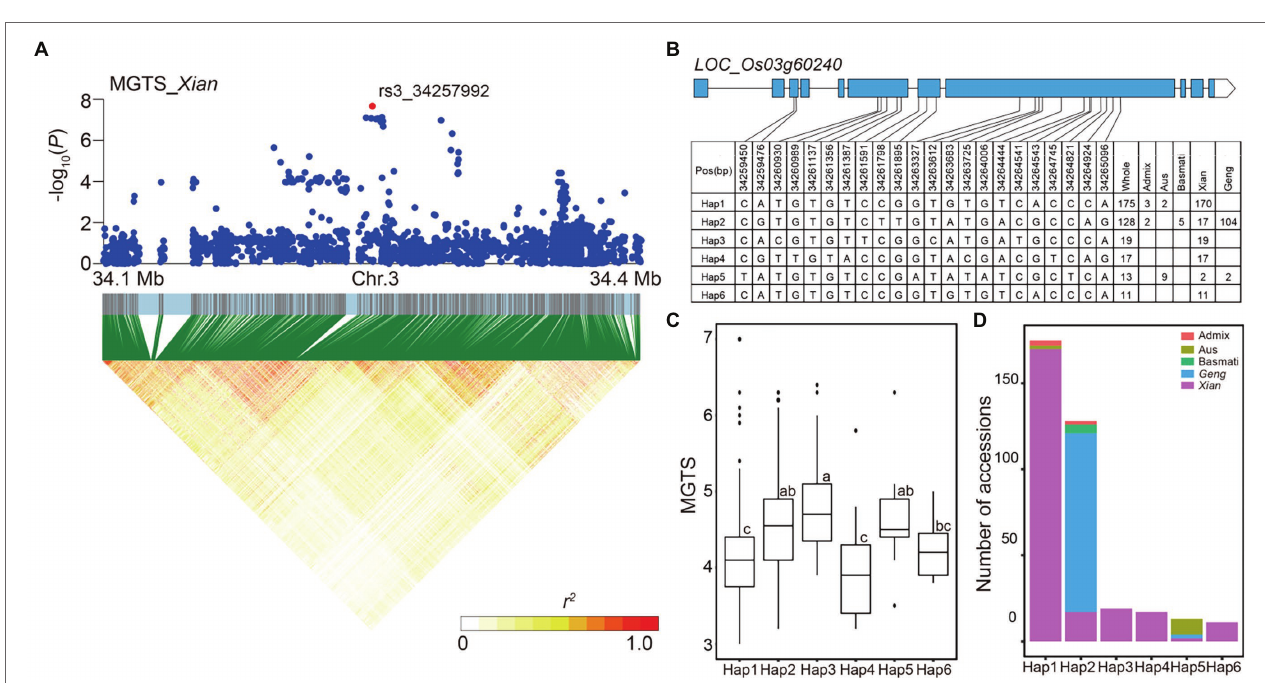
FIGURE 4 | Candidate gene analysis of locus 71 on chromosome 9. (A) Local Manhattan plot (top) and LD heat map (bottom) of locus 71 for RRL in the whole population. The red dot indicates the lead SNP rs9_14985169 and the position of candidate gene LOC_Os09g25060 . (B) CDS-haplotypes of LOC_Os09g25060 . (C) The distribution of RRL in the whole population for the three haplotypes of LOC_Os09g25060 . Different letters above each boxplot indicate significant differences among haplotypes according to Duncan’s multiple range post-hoc test ( p < 0.05). (D) Frequency of three haplotypes of LOC_Os09g25060 in subpopulations.